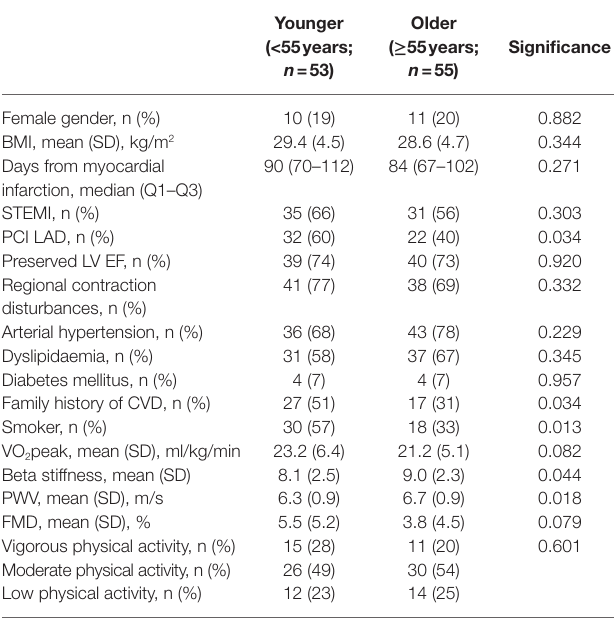
TABLE 1 | Baseline characteristics. TABLE 2 | Baseline characteristics according to